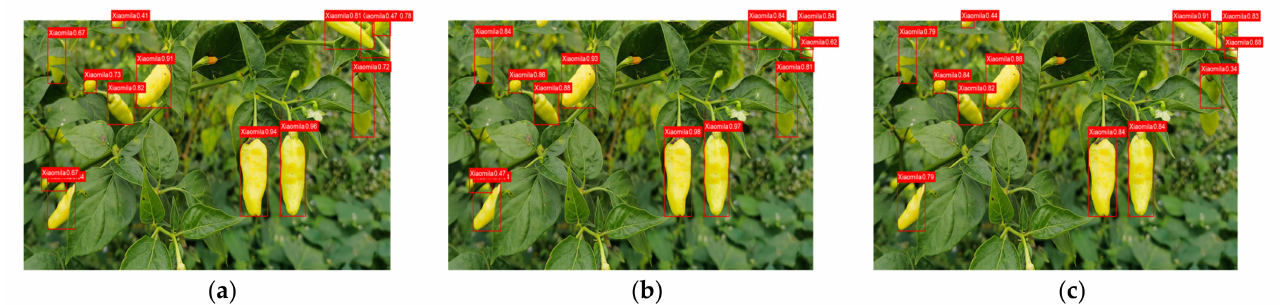
Figure 11. Comparison of the detection results of different models in the morning with YOLOv5s-CFL, YOLOv5s, and YOLOv3-tiny respectively. ( a ) YOLOv5s-CFL. ( b ) YOLOv5s. ( c )